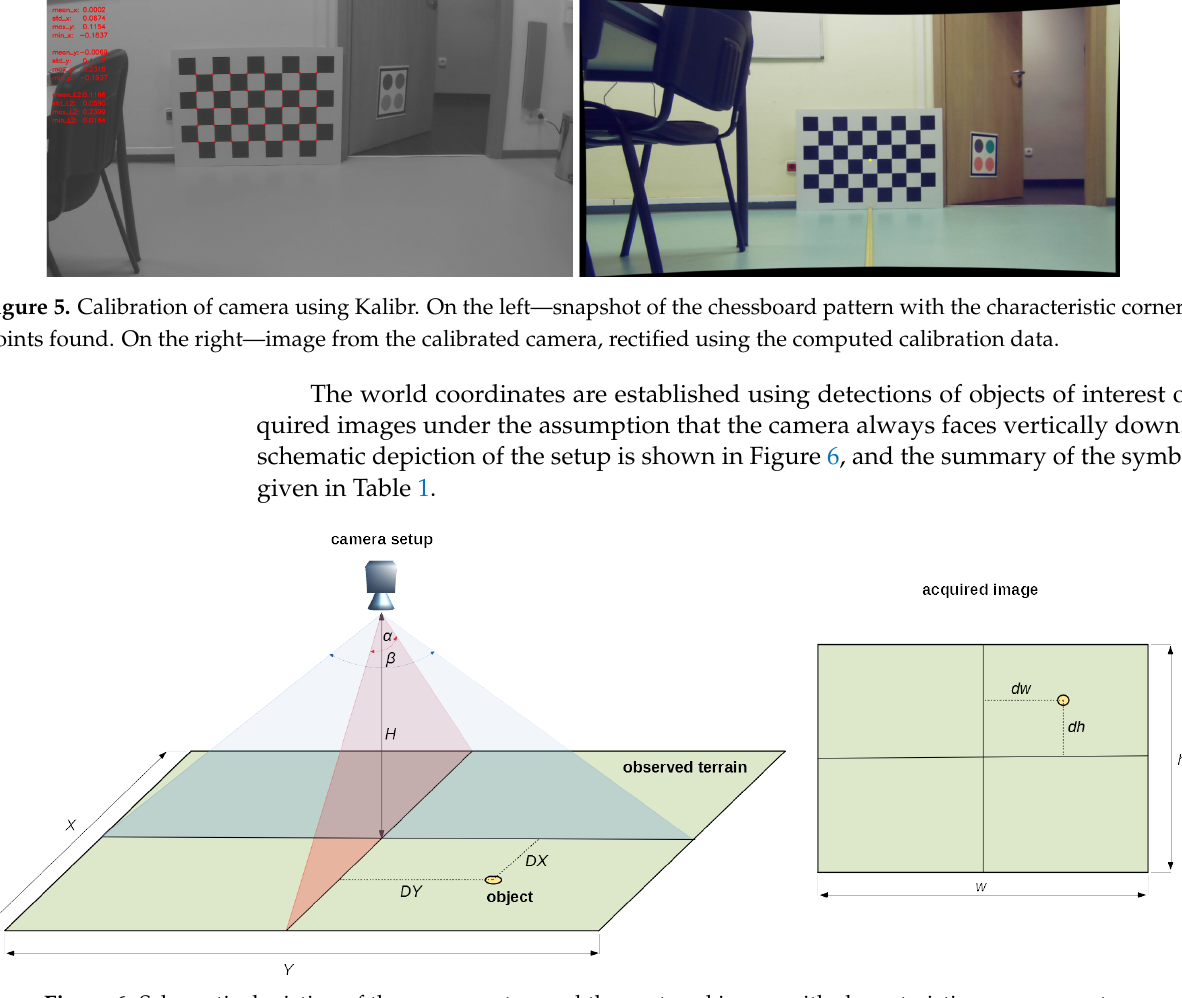
Figure 6. Schematic depiction of the camera setup and the captured image with characteristic measurements. Table 1. Description of designations used in Figure 6 and in further